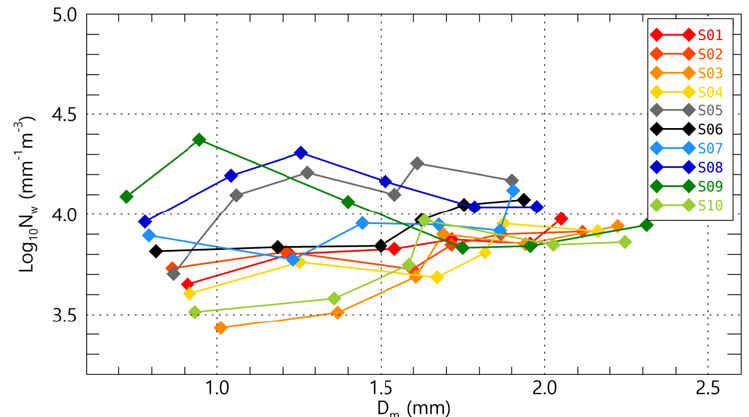
Figure 8. The average N w versus D m for the rain rate categories at the 10 Parsivel sites. The different colors indicate each Parsivel site and each symbol from left to right on the same color line represents rain rate categories.